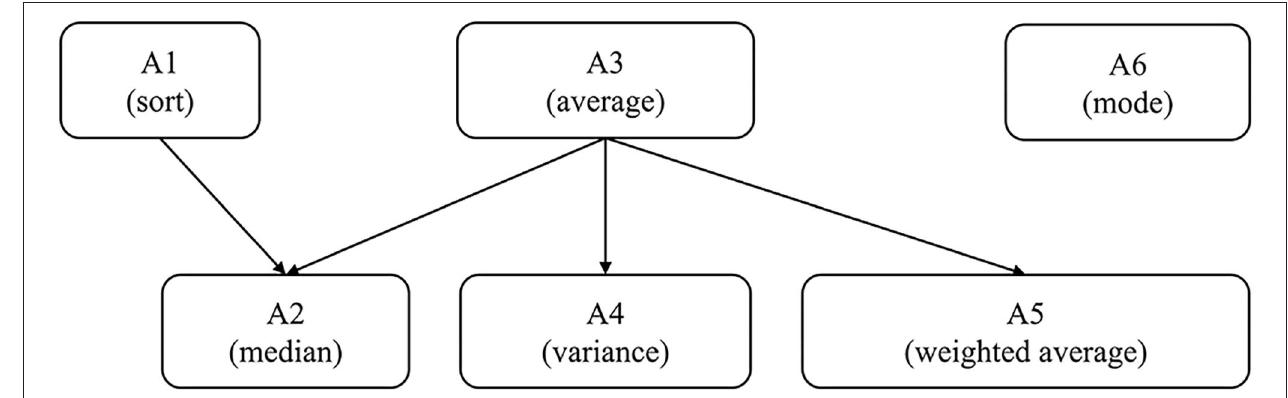
FIGURE 1 | The hierarchical structure of the six attributes of this study.